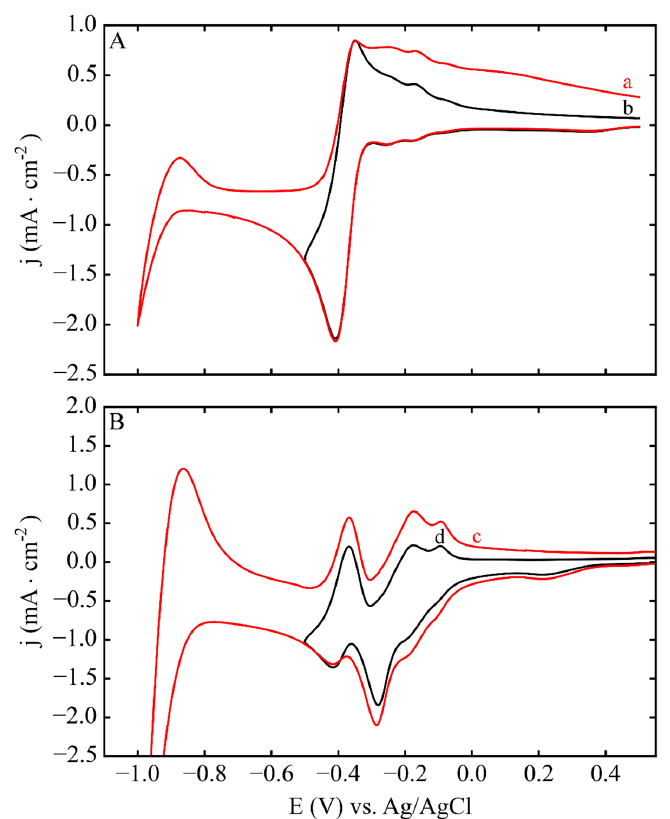
Figure 2. Cyclic voltammetry of a 1.6 mm Pt electrode in ( A ) 0.5 M NaCl pH 2.3 (no Pt) and ( B ) in the same electrolyte in (A) +3 mM H2PtCl6. CVs (a,c) and (b,d) were recorded in different potential windows, ν = 50 mV/s. Nanomaterials 2018 , 8 , x FOR PEER REVIEW